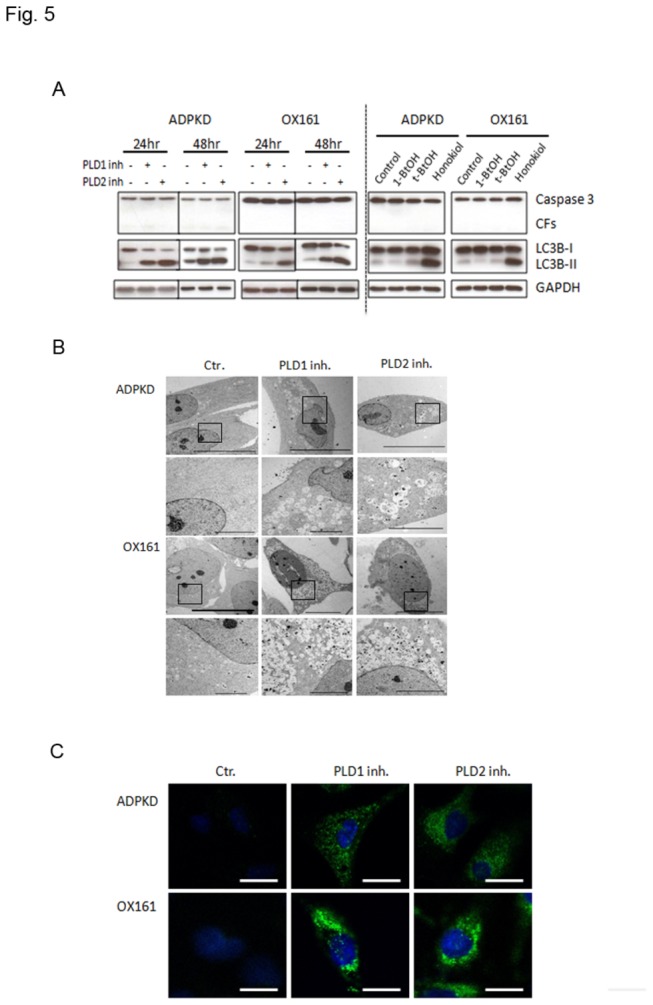
PLD inhibitors trigger autophagosome formation.(A) PLD inhibitors induced autophagy in a time-dependent way. Left panel: PKD cells were treated by either 10 µM PLD1 inhibitor or 20 µM PLD2 inhibitor for 24 h and 48 h. Right panel: PKD cells were plated for 24 h and then shifted to medium containing 0.5% serum. 1% 1-BtOH or 1% tert-BtOH was added for 2 h, 20 µM honokiol was added for 20 h. Western blots analyzing the expression of caspase-3, LC3B and GAPDH. (B) Transmission electron microscopy analysis of PLD1 and PLD2 inhibitor-treated HAK and OX161 cells (10 µM and 20 µM respectively, 48 h) showing intensive vacuolization and autophagosome-like vesicles. The lower panels show the magnification of the black frame area in the upper panels for each type of cell. The scale bar in the upper and lower panels represents 10 µm and 5 µm respectively. (C) Immunofluorescence microscopy analyzing autophagosome distribution after PLD1-/2- inhibitor (10 µM and 20 µM) treatment for 48 h. Cells were stained with anti-LC3B antibody. Scale bar represents 20 µm. Representative of three independent experiments.